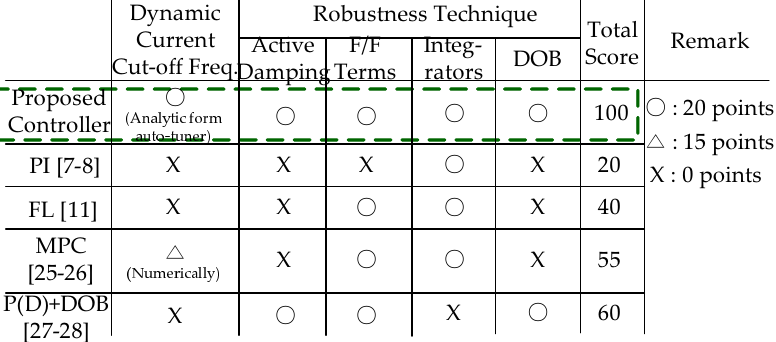
Figure 1. Qualitative comparison results.